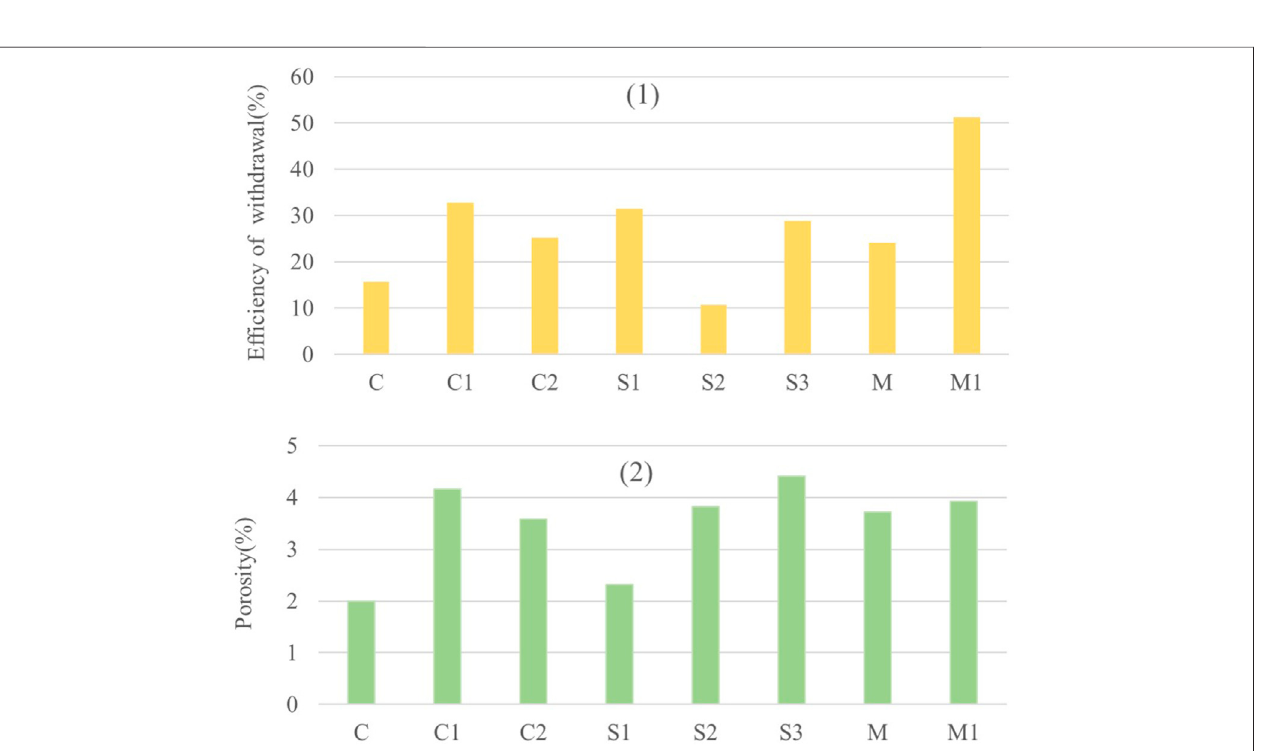
FIGURE 9 | Comparison of the ef fi ciency of mercury withdrawal and porosity in different lithofacies.